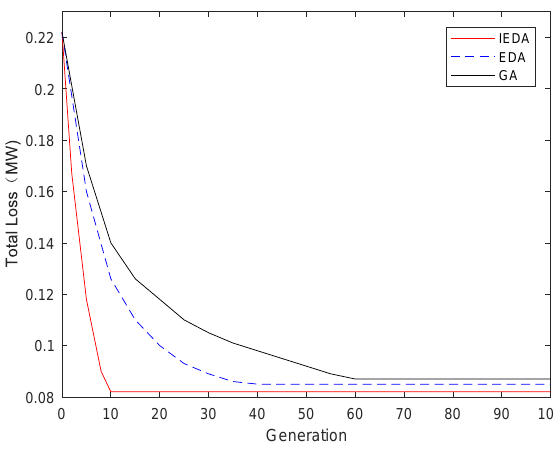
Figure 11. The 69 bus radial distribution system.